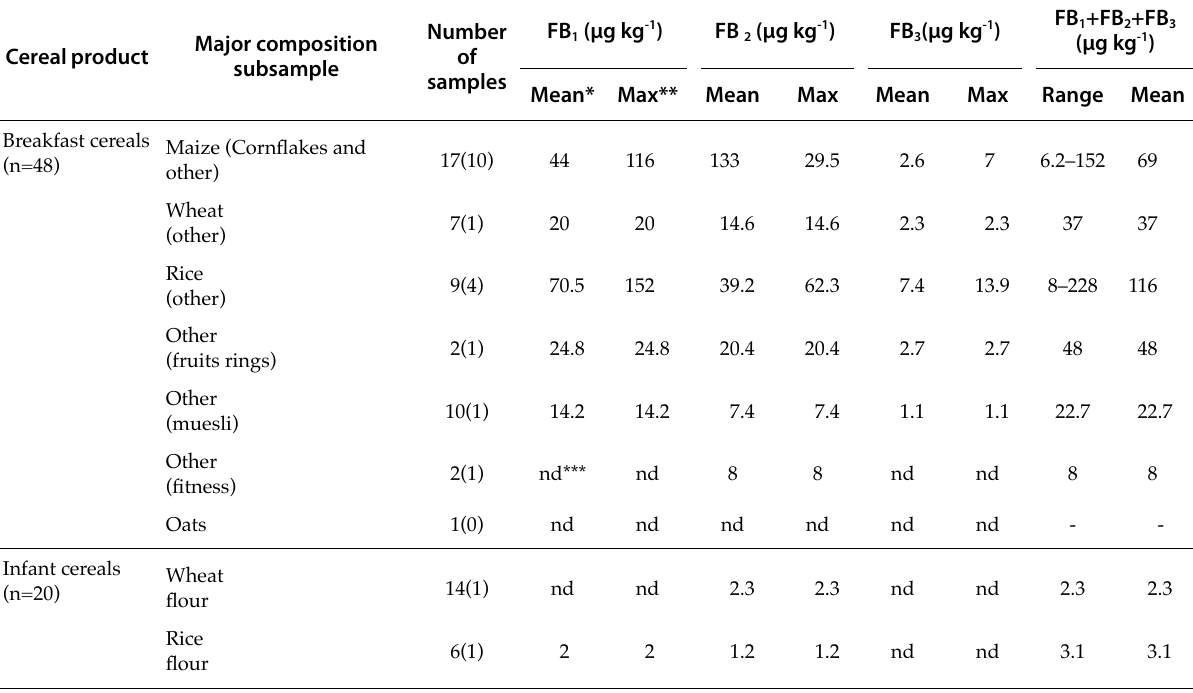
Table 1. Levels of FBs in breakfast and infant cereals from Morocco. Major composition Cereal product